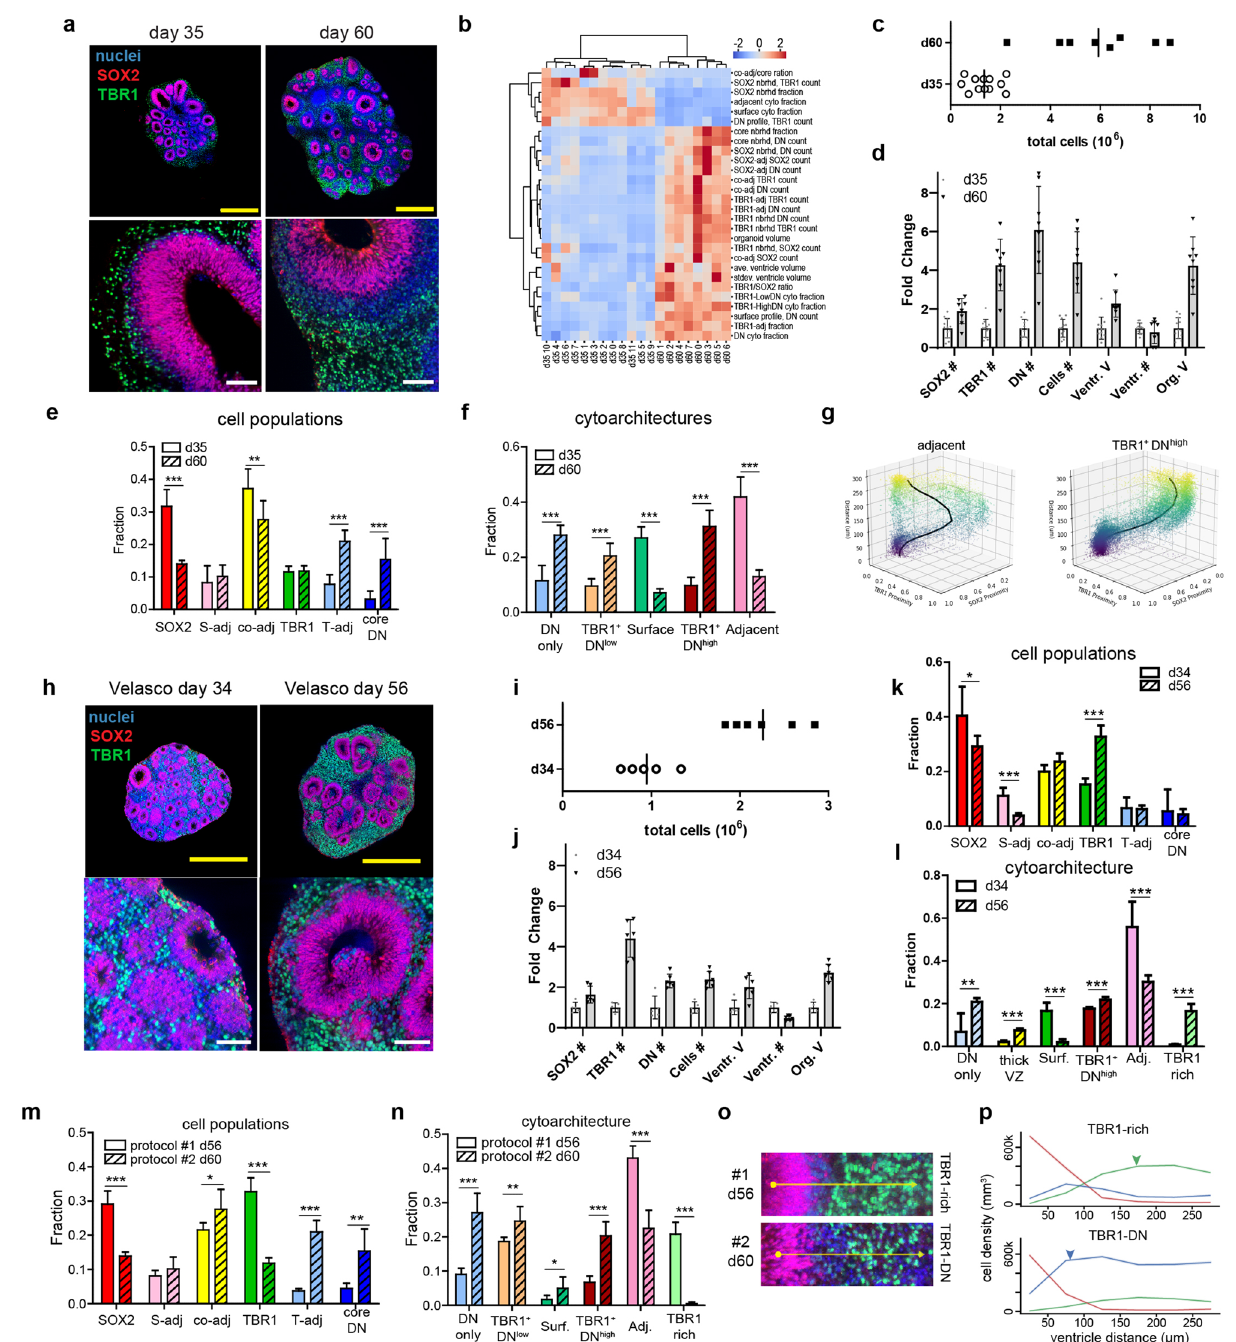
Figure 5. Hyper-dimensional analysis of multiscale changes during cerebral organoid development. ( a ) Representative image of day 35 and day 60 undirected organoids taken from volumetric datasets. Scale bars yellow = 1 mm and white = 100 µm ( b ) Heat map outlining major differences between day 35 (n = 12) versus day 60 (n = 8) organoids. ( c ) Dot plot showing total cell counts for all organoid replicates in each age group. ( d ) Fold-change in total cells, average ventricle volume, and total counts of cell populations. ( e ) Average frequency of cell subpopulations and ( f ) cytoarchitecture clusters in different age groups ( g ) Analysis of cell proximity to SOX2 and TBR1 in “adjacent” (left) and “TBR1, DN high ” (right) as a function of the distance from the ventricle surface. ( h ) Representative image of Velasco organoids at day 34 (n = 5) and day 56 (n = 6) taken from volumetric datasets. Scale bars: yellow = 1 mm and white = 100 µm ( i ) Dot plot showing total cell counts of Velasco organoid replicates in each age group. ( j ) Fold-change in total cells, average ventricle volume, and total counts of antibody-labeled subsets in Velasco organoids. ( k ) Average frequency of cell subpopulations and ( l ) cytoarchitecture clusters in different age groups of Velasco organoids. ( m ) Comparative analysis of cell subsets in day 60 organoids from panel a (protocol #1) and d56 Velasco patterned organoids from panel h (protocol #2). ( n ) Comparison of cytoarchitecture clusters in protocols 1 and 2. ( o ) Representative image of cytoarchitecture most common in protocol 1 (TBR1-rich) and protocol 2 (TBR1 + DN high) organoids. Arrow is a virtual cortical column 300 µm in length. ( p ) Radial distribution of SOX2 (red), double negatives (blue) and TBR1 (green) cells in the cytoarchitectures shown in subpanel o. Arrows show the higher TBR1 frequency (green) and DN band between SOX2 and TBR1 (blue). [*** p < 0.001, ** p < 0.01, * p <